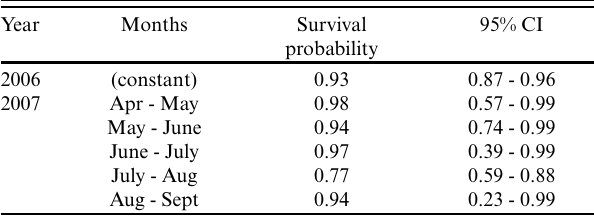
Table 4 . Estimated monthly survival for male Bachman’s Sparrows ( Peucaea aestivalis ) in 2006 and 2007 based on the most parsimonious models provided in Table 3.